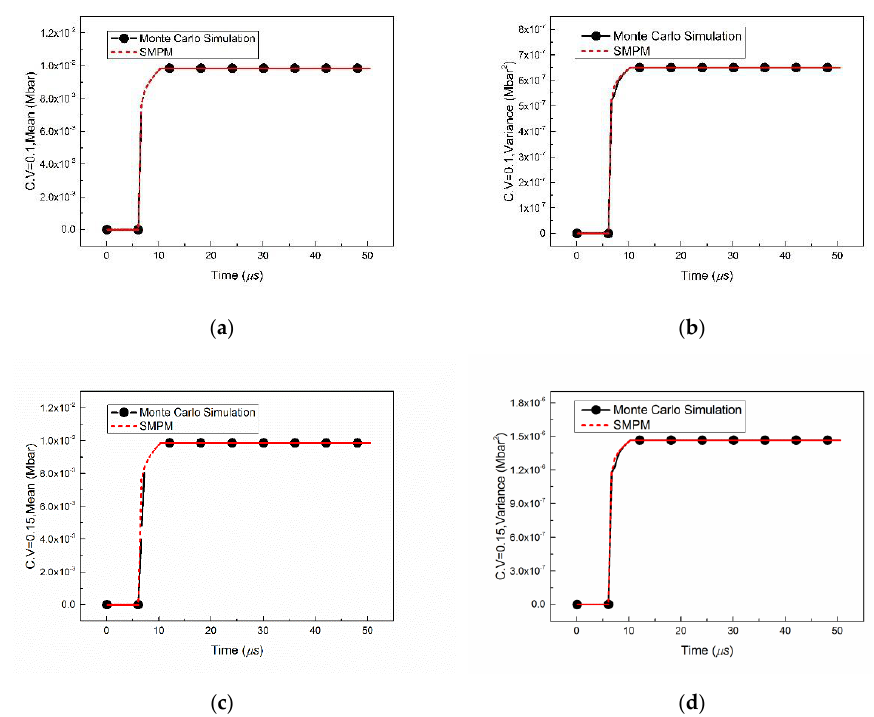
Figure 10. Equivalent plastic stress σ y response of location I by various methods with C.V = 0.1 and C.V = 0.15: ( a ) Mean of σ y with C.V = 0.1; ( b ) Variance of σ y with C.V = 0.1; ( c ) Mean of σ y with C.V = 0.15; ( d ) Variance of σ y with C.V = 0.15.